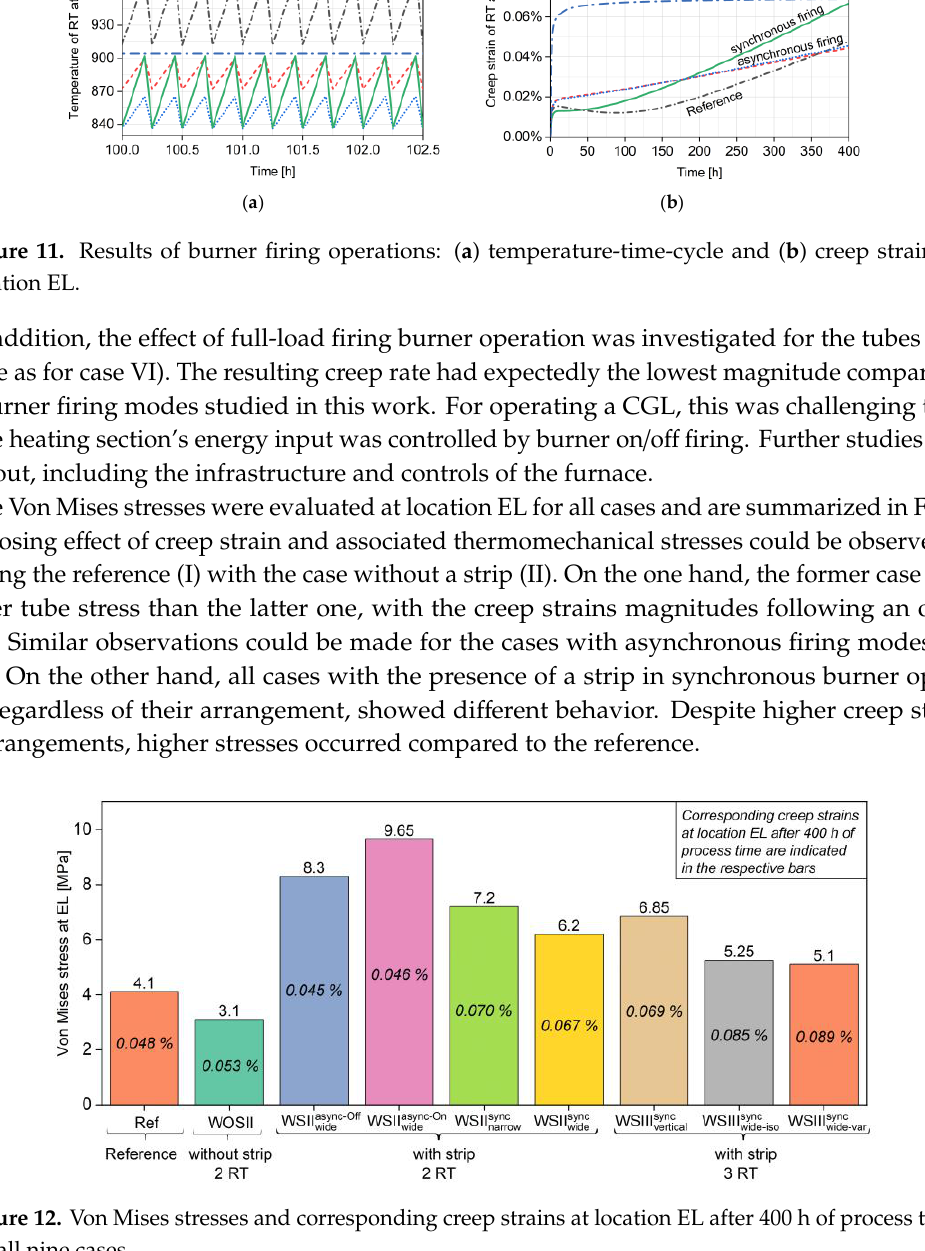
Figure 12. Von Mises stresses and corresponding creep strains at location EL after 400 h of process time for all nine